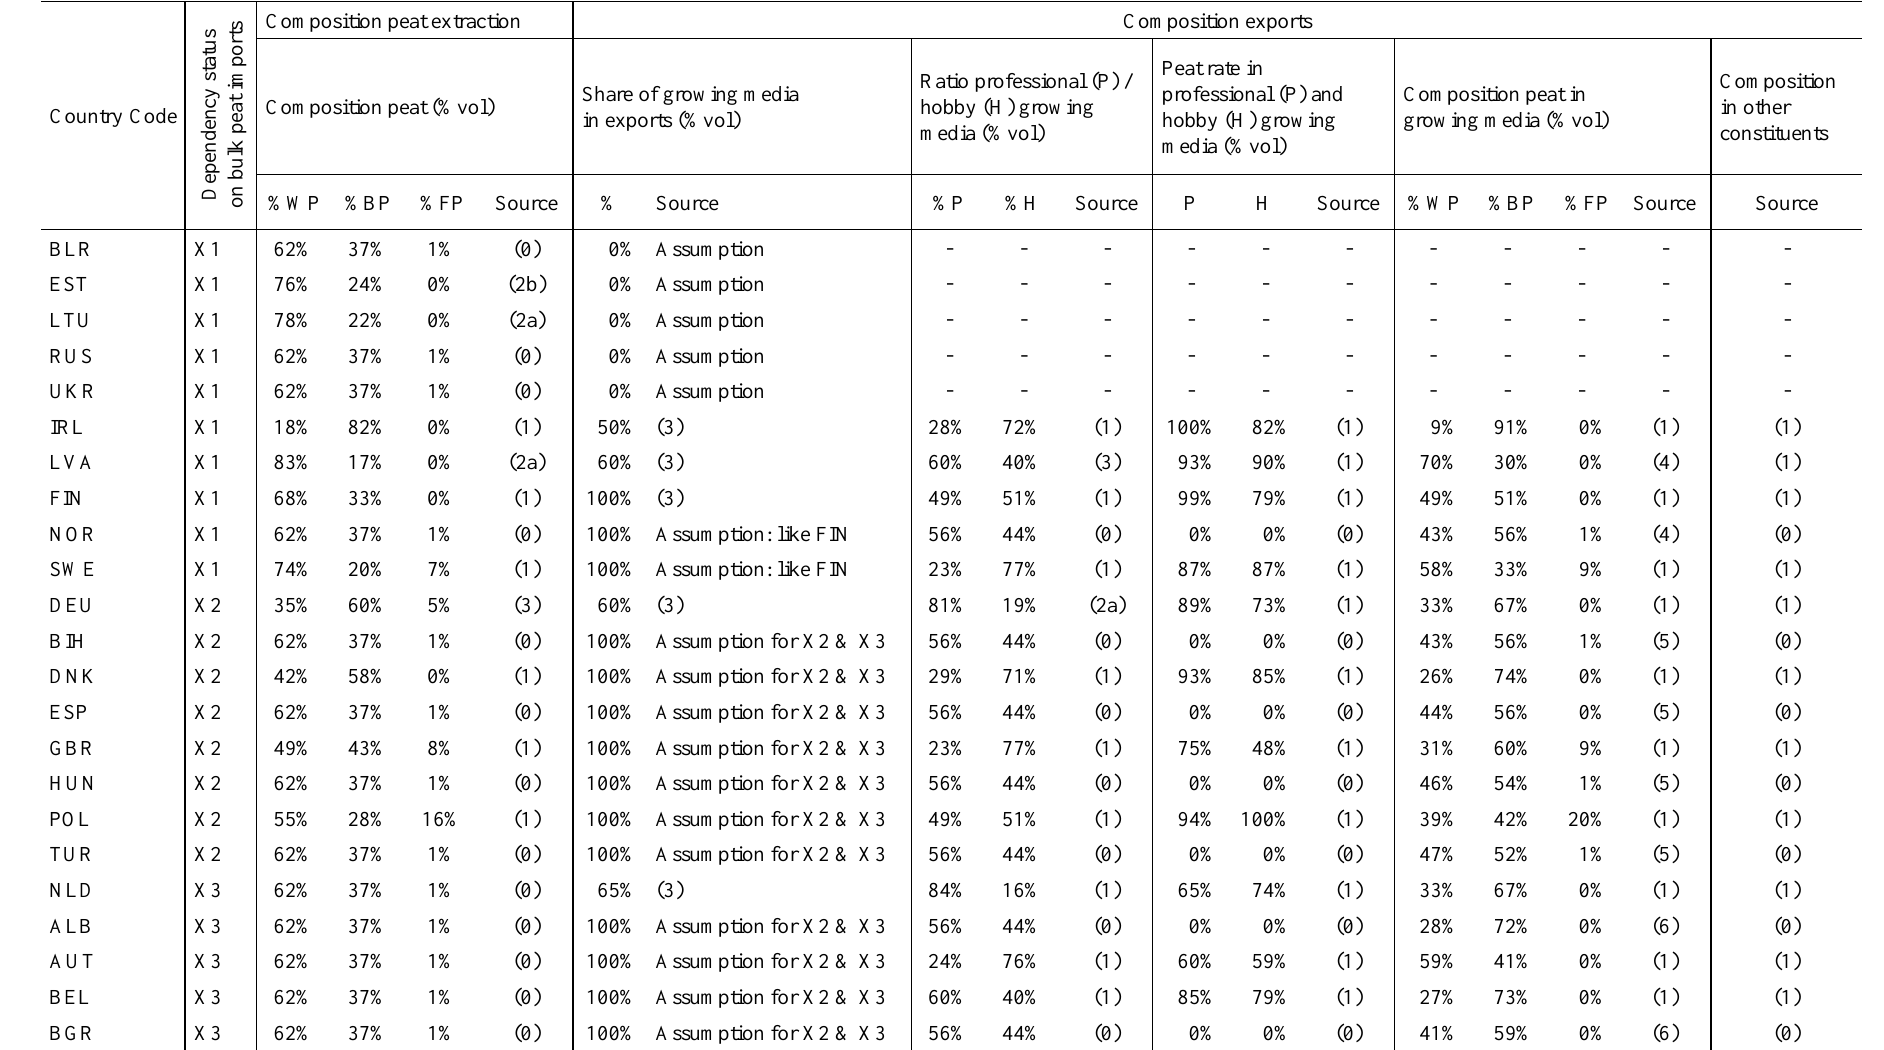
Table A5. Composition of non-energy peat extraction and exports as a result of the modelling process.